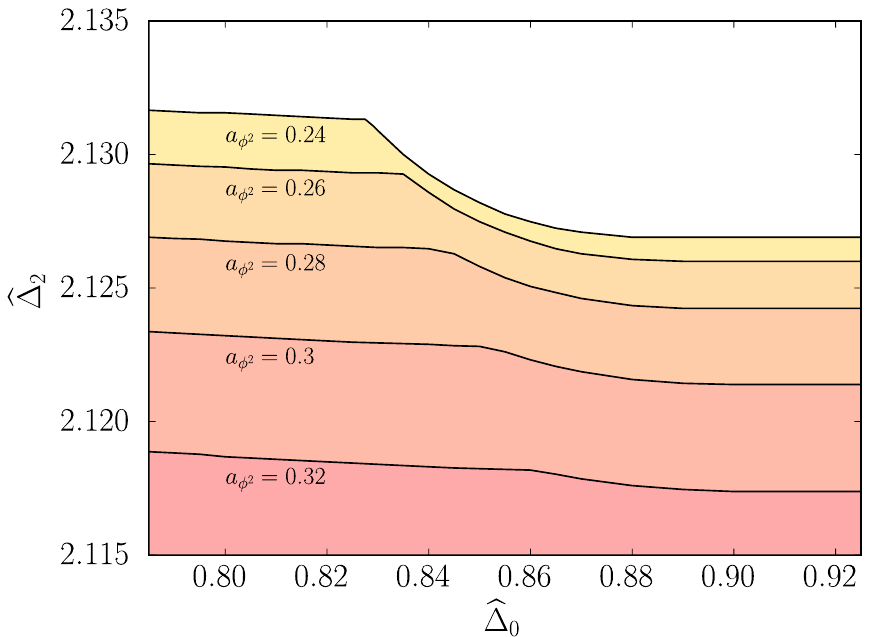
Figure 6. Allowed regions analogous to figure 5 which come from following the upper left kinks there to five larger values of a . For the nearly smoothed out boundary at a φ 2 values of interest have almost converged. Notice that the sharp cliff corresponding to the minimal model boundary condition lies further to the right, outside the range of this